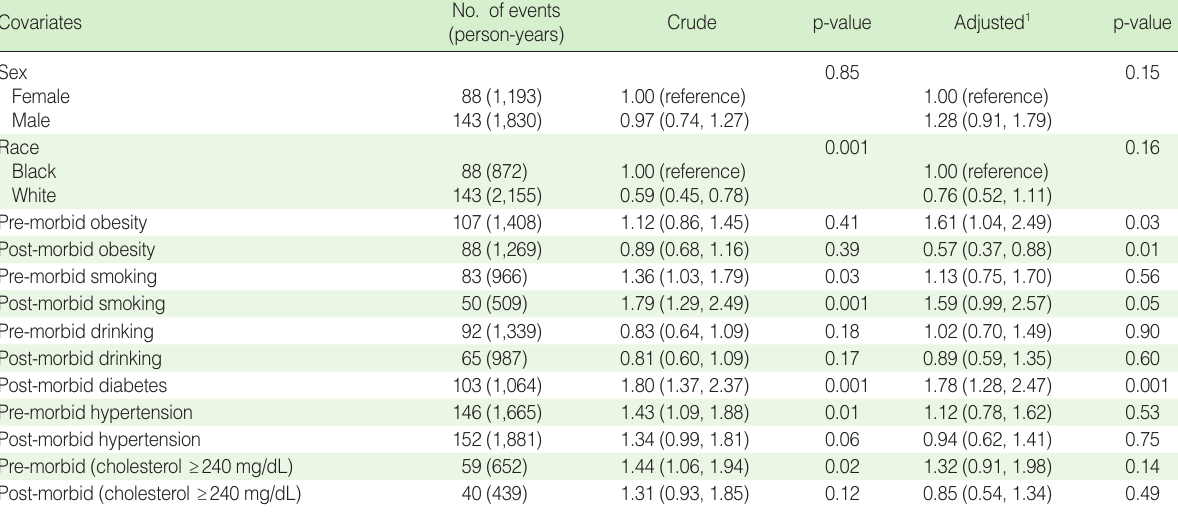
Table 2. Crude and multivariate adjusted model for all-cause mortality in patients with incident heart failure Covariates